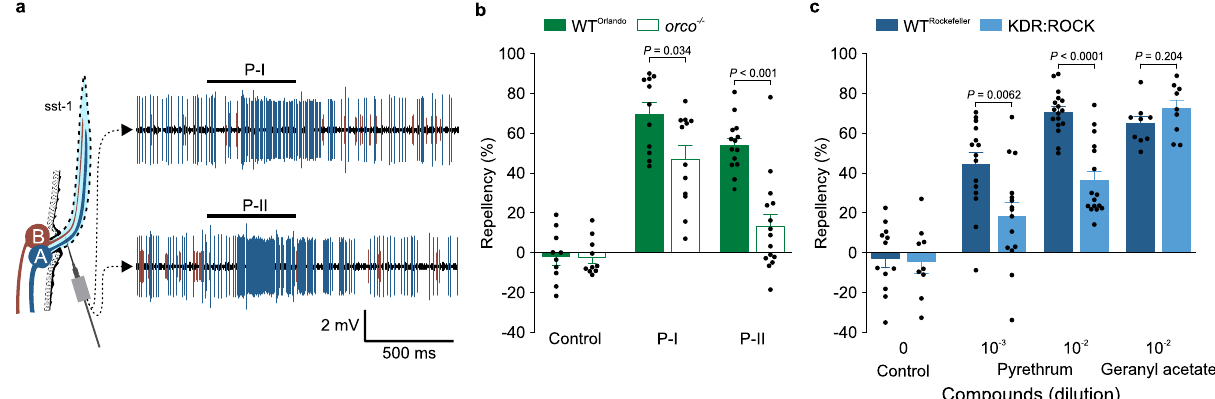
Fig. 5 Pyrethrin repellency is the result of activation of both Or(s) and sodium channels. a Representative single sensillum recording (SSR) traces of short sharp-tipped (sst)-1 sensilla responding to pyrethrin I (P-I; n = 8 sensilla) and pyrethrin II (P-II; n = 6 sensilla) at the 10 − 1 dilution from Rockefeller mosquitoes. b Repellency elicited by P-I and P-II at the 10 − 3 dilution in Orlando (wild-type) and orco − / − mosquitoes ( n = 10 cages for Orlando control and orco − / − control from 2 batches of mosquitoes; P-I: U = 31, P = 0.034, n = 11 cages for Orlando and n = 12 cages for orco − / − from 3 batches of mosquitoes; P-II: U = 15, P < 0.001, n = 14 cages for Orlando and n = 15 cages for orco − / − from 4 batches of mosquitoes). c Repellency by pyrethrum and